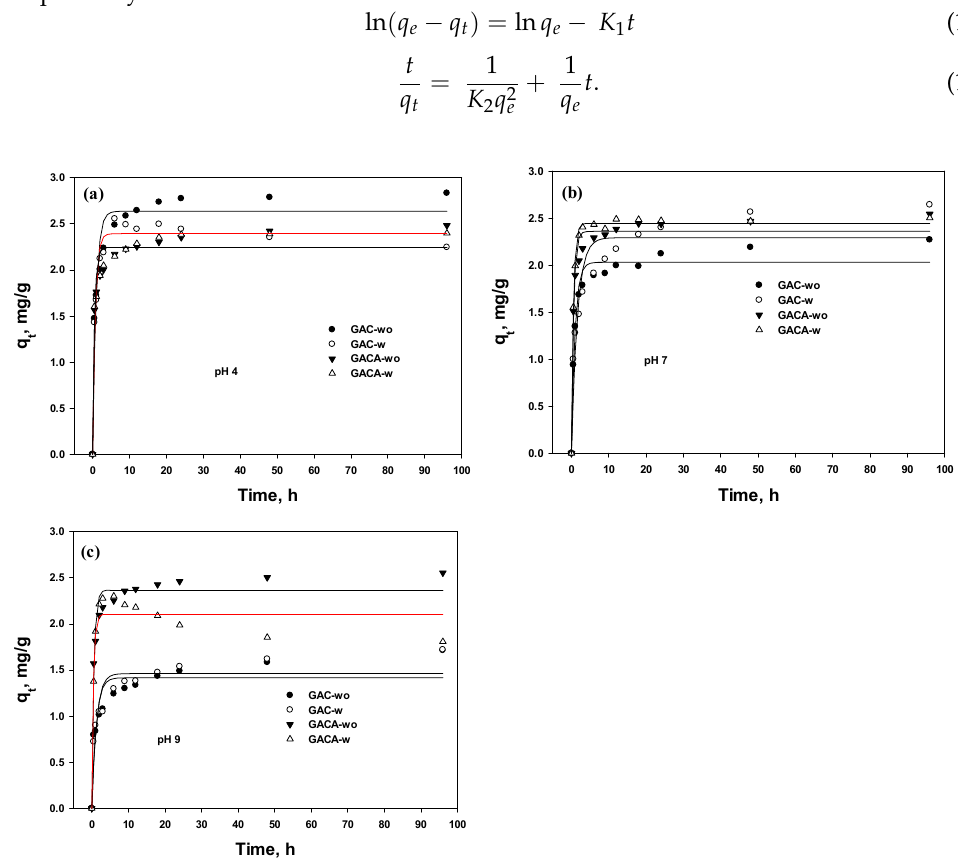
Figure 7. Nonlinear pseudo-first-order (PFO) kinetic for GAC and GACA at initial pH of 4 ( a ), 7 ( b ), and 9 ( c ) (red lines indicate the phosphate desorption experiment).